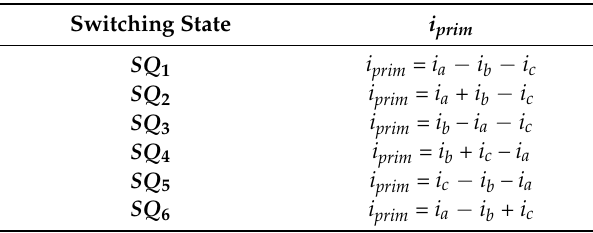
Figure 4. Ideal wavfeorms: ( a ) Voltage v xy ; ( b ) voltage v sec ; and ( c ) current through the transformer, i LS . Table 3. i LS magnitude for each switching state.